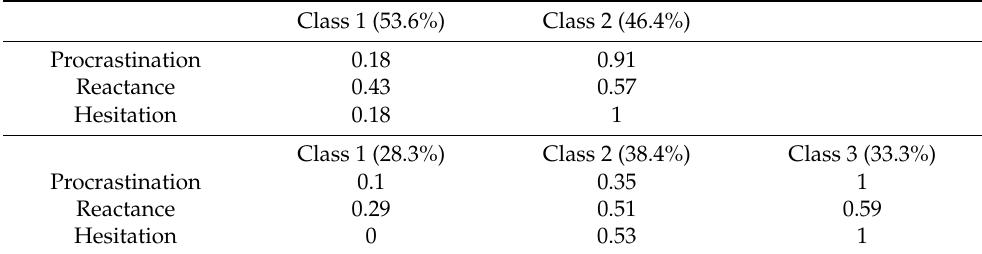
Table 3. Conditional probabilities and proportion